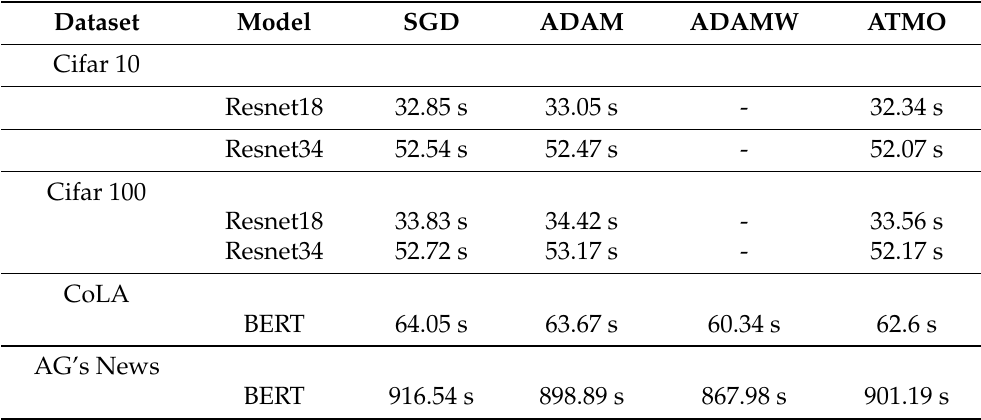
Table 5. Mean computational time for one epoch in seconds (s) for each experiment. We computed the train and test time